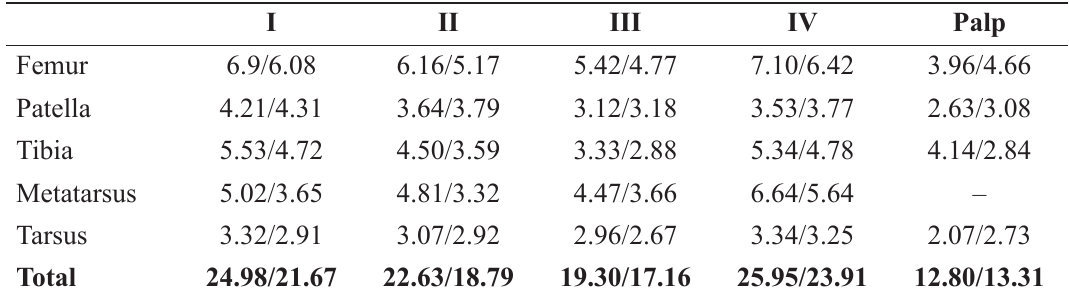
Table 1. Length of legs and palpal segments of holotype, ♂ (MZSP 47440) / paratype, ♀ (MZSP 47427) of Schismatothele caeri sp.